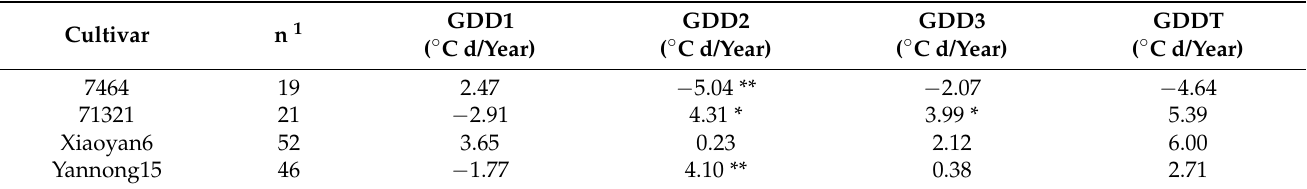
Figure 1. Growing degree days (GDD) of winter wheat as impacted by climate change. ( A ) displays the variations in GDD with different cultivars, and ( B ) displays the variations in GDD at different stations of one cultivar (Yannong15). Blue, green, yellow and red indicate the GDD from sowing to jointing (GDD1), from jointing to anthesis (GDD2), from anthesis to maturity (GDD3), and from sowing to maturity (GDDT), respectively. Lines extend from 5th to 95th percentile of GDD, boxes extend from 25th and 75th percentile, and the middle vertical line within each box indicates the median GDD. Table 3. Temporal trends of growth degree days during the different growth periods of winter wheat for four different